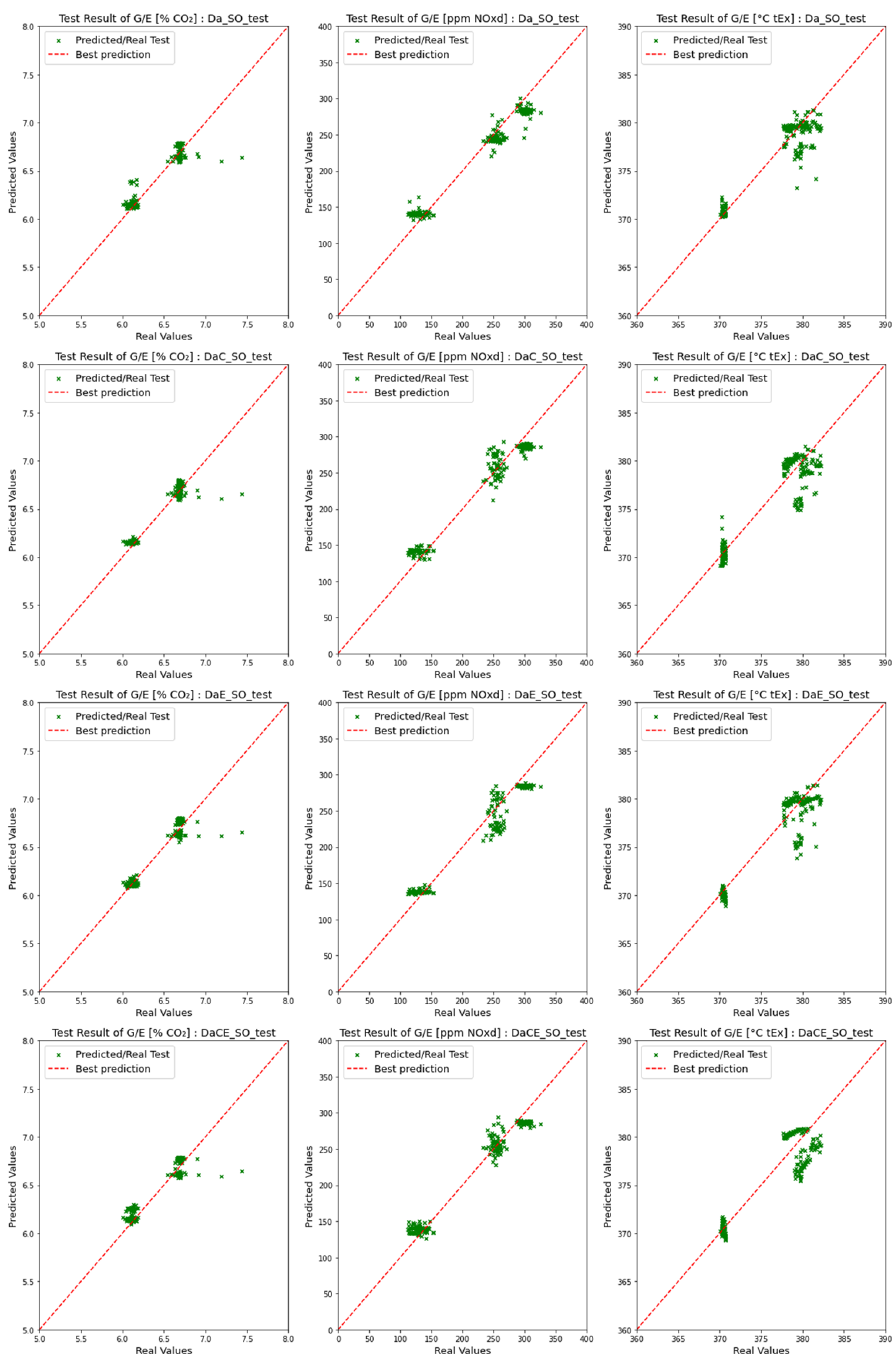
Figure 12. Comparison of dataset performances for ANN model with the SCR mode.